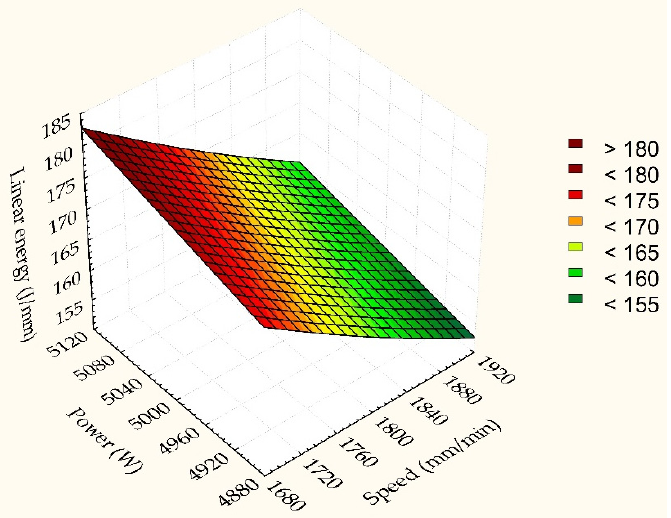
Figure 6. Linear dependence of linear energy as a function of speed and laser power.